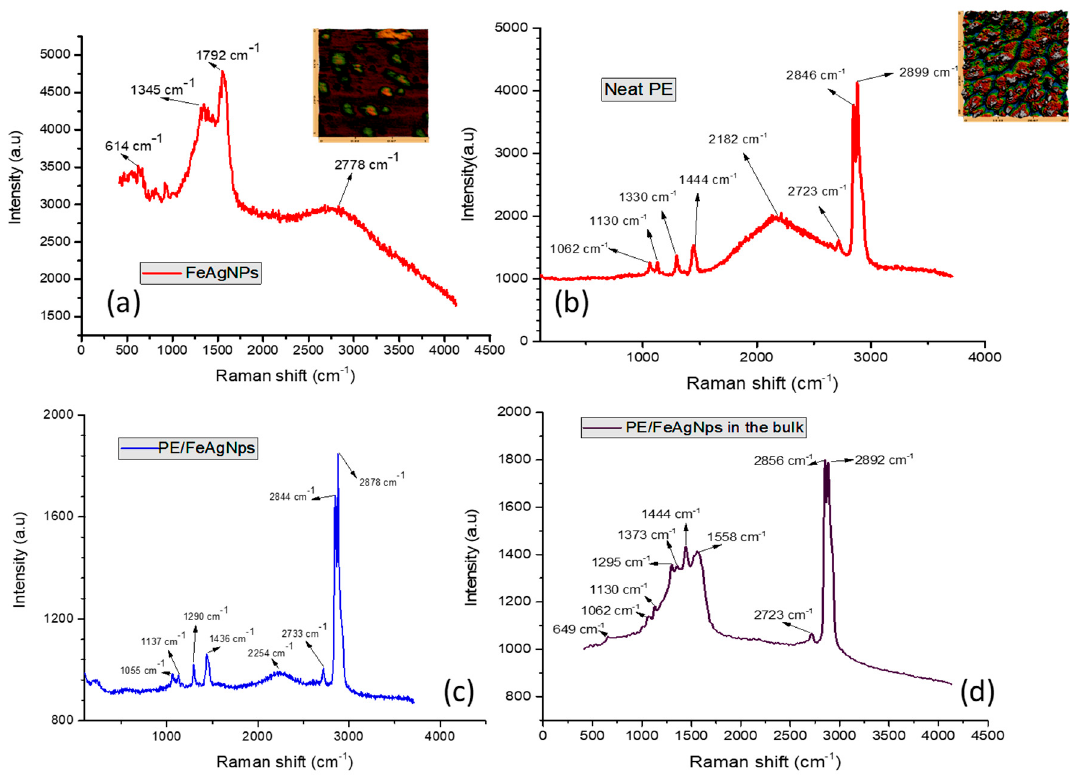
Figure 8. Raman spectra of ( a ) FeAg NPs; ( b ) neat HDPE, ( c ) PE/FeAg NPs and ( d ) HDPE/FeAg Nps in the bulk. Inserted figures show corresponding AFM